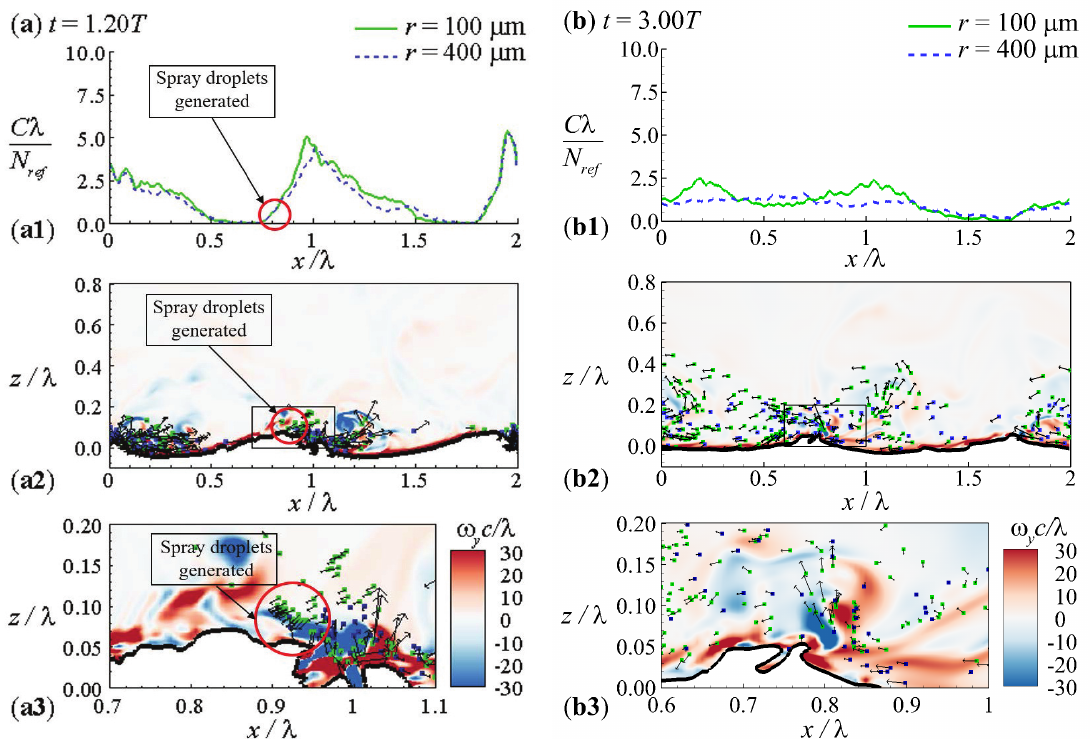
Figure 9. See Figure 3 for the caption. Here, the results of Case C55 at ( a ) t = 1.20 T and ( b ) t = 3.00 T are shown